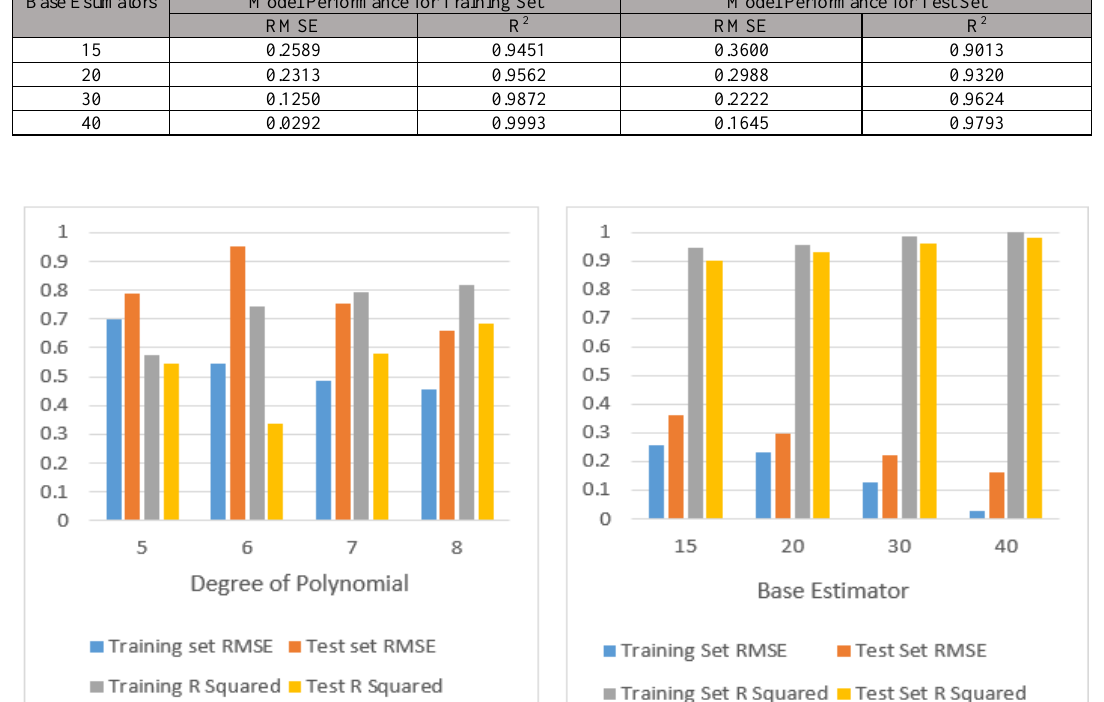
Figure 9. The performance of polynomial linear regression model for 5,6,7, and 8 degrees of polynomials (5,6,7, and 8) and GBF regression model performance for 15, 20, 30, and 40 dimension GBF